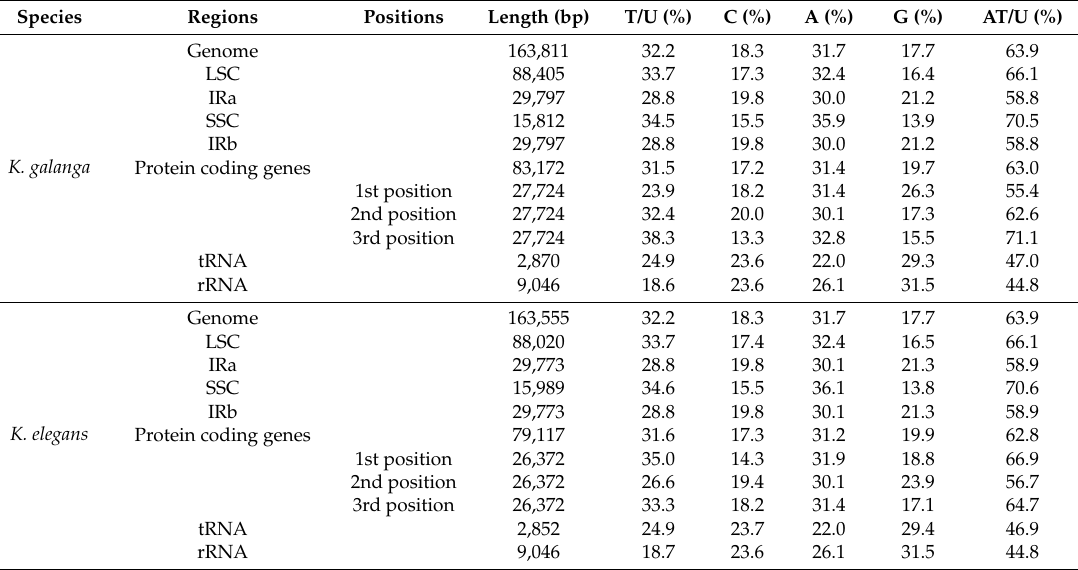
Table 1. Features of the chloroplast genomes of K. galanga and K. elegans . Species